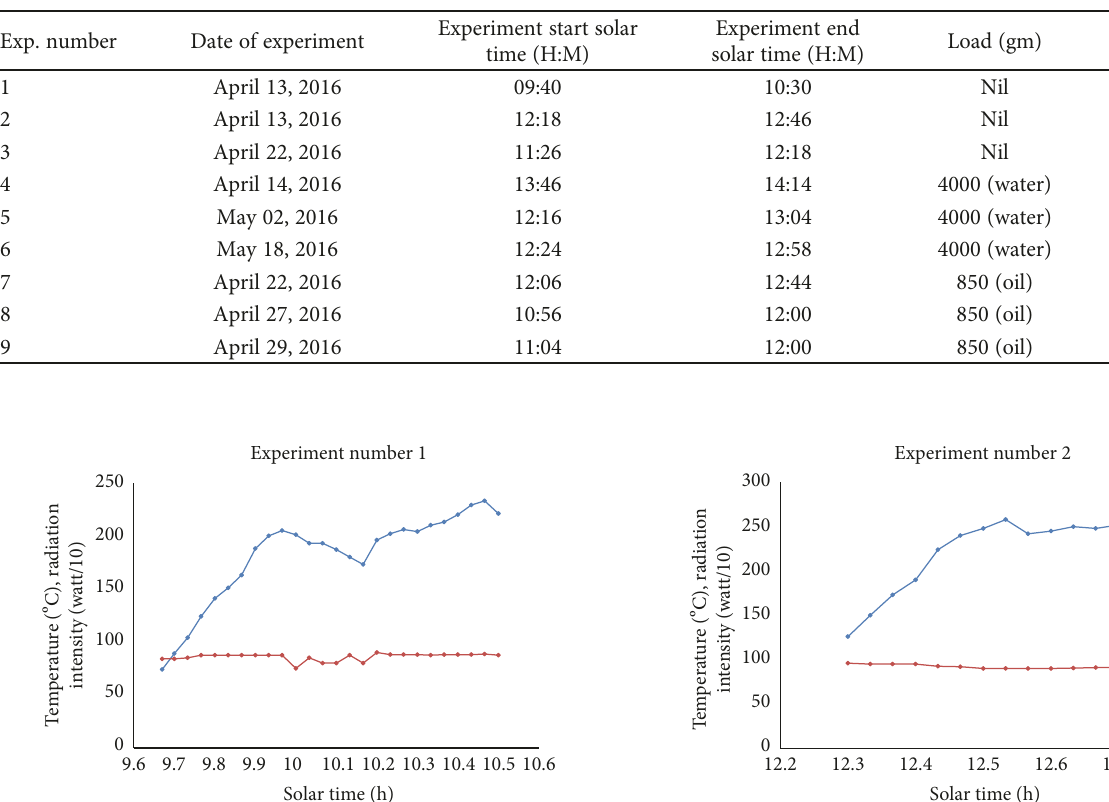
Table 1: Test conditions of nine experiments.